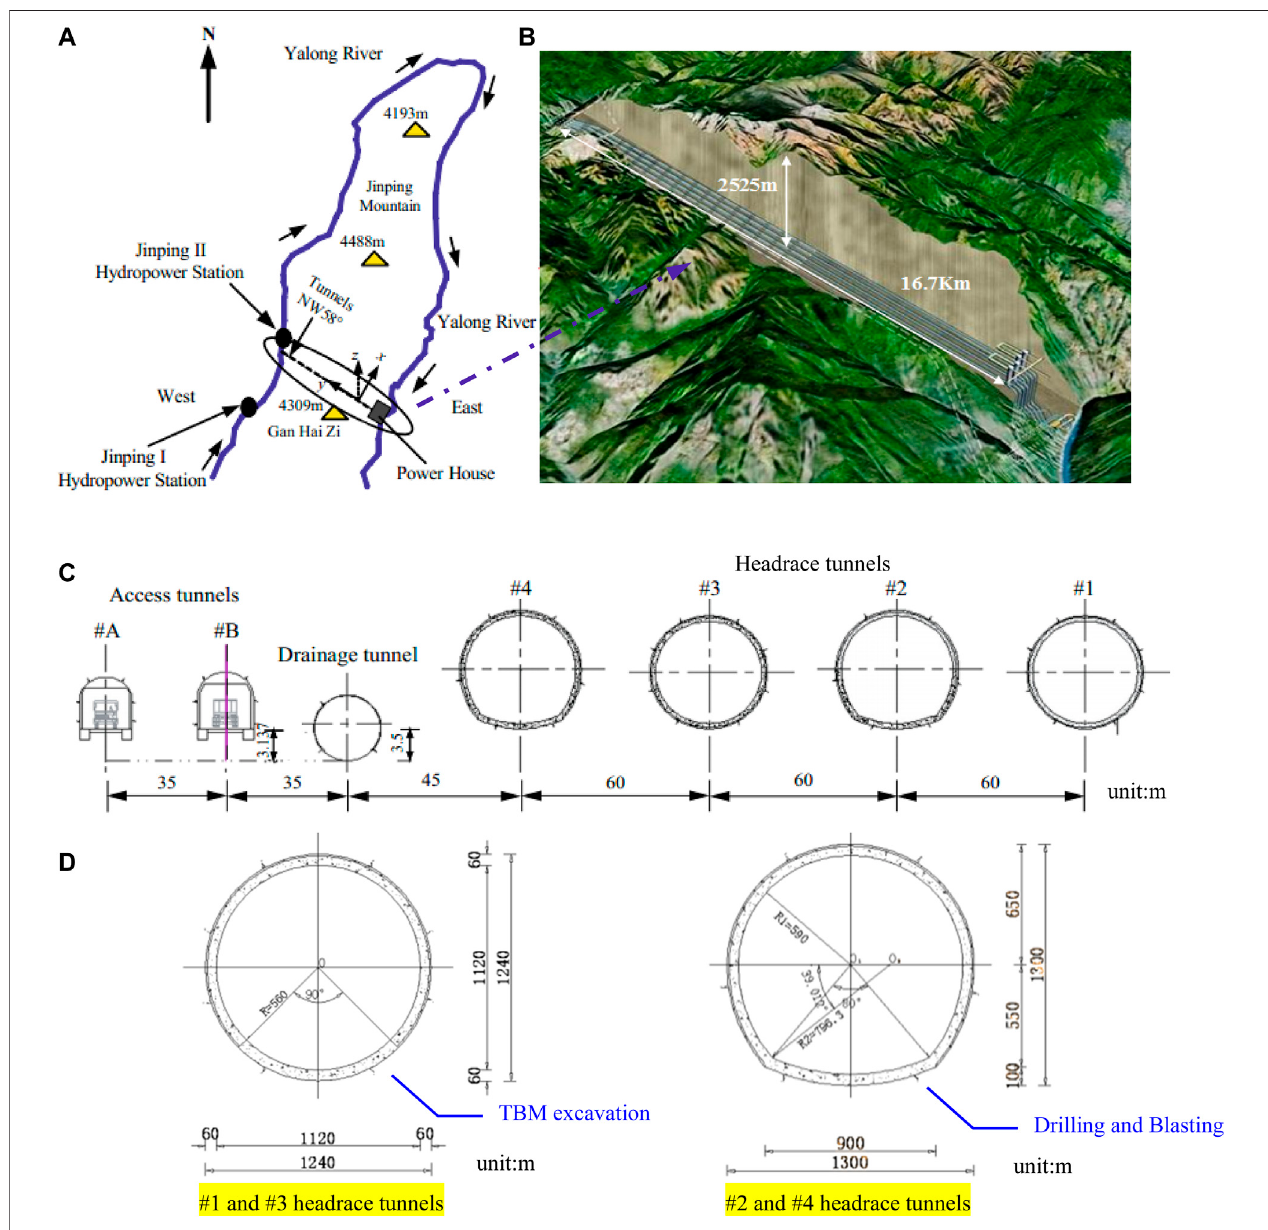
FIGURE1| LayoutandlocationoftunnelsattheJinpingIIhydropowerstation. (A) LayoutoftheJinpinghydropowerprojectacrosstheYalongRiver; (B) locationof the Jinping II Hydropower Station; (C) coniguration of seven tunnels; and (D) the construction detailed dimension drawing for the headrace tunnel and drainage tunnel.